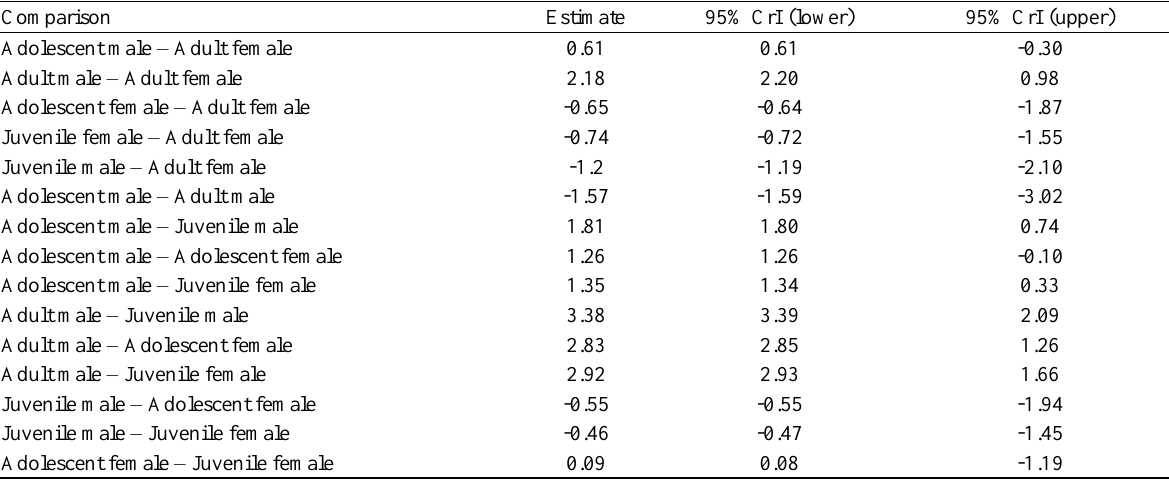
Level of Vigilance During Approaches: Multiple Comparisons Between All Approacher Age-Sex Classes